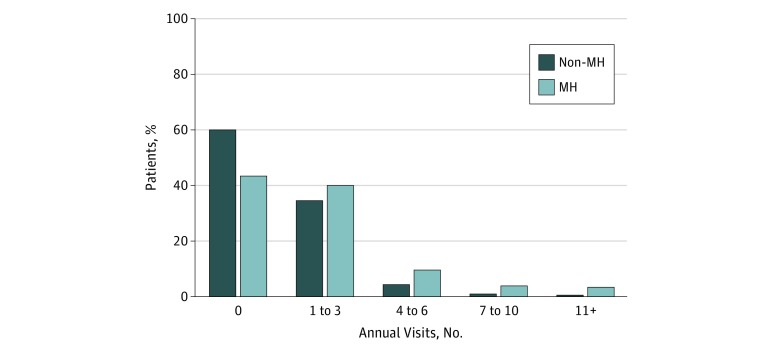
Distribution of Patient Visits by Presence of Any Mental IllnessMH indicates mental health.